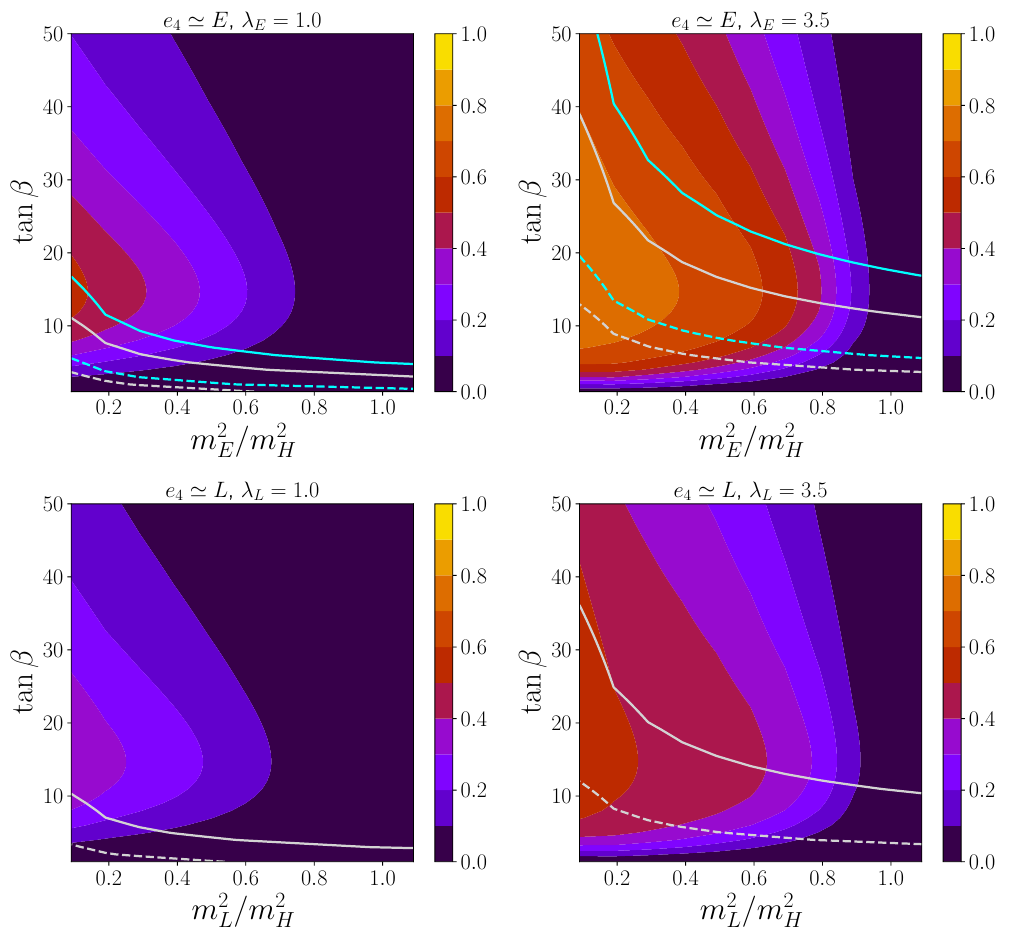
Figure 16 . Branching fractions of the leptonic cascade decay, H → µe 4 → V ‘ 2 µ , for m H = 1 TeV . G F ( R µ ) is more than 2 σ away from the measured value below the cyan (gray) solid line. The EWPO constraints for m H = 3 TeV are shown by the dashed